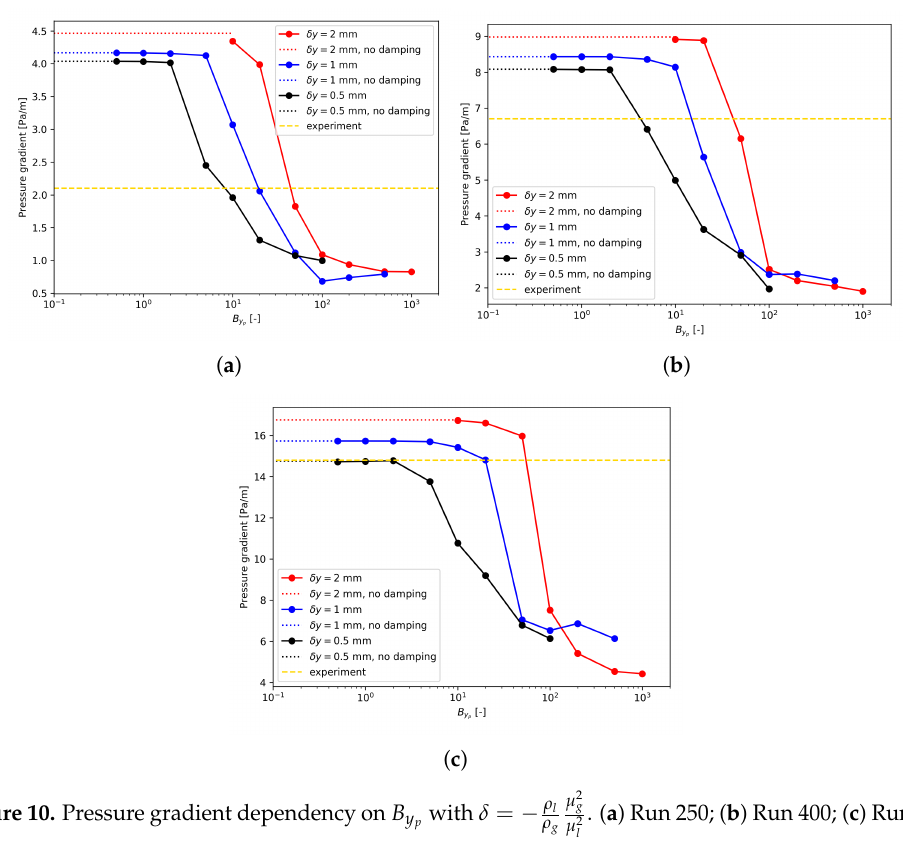
Figure 10. Pressure gradient dependency on B y